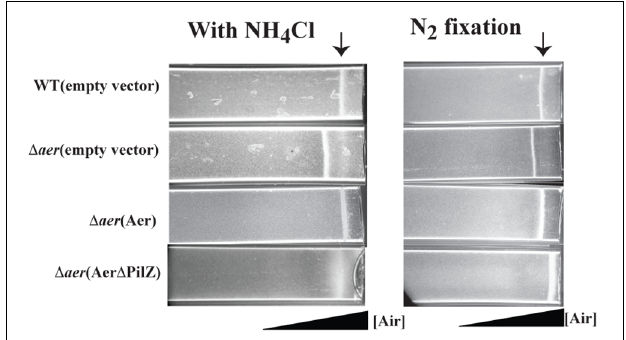
FIGURE 2 | Effect of loss of Aer on oxygen sensing in a spatial assay for aerotaxis. Cells grown in presence of ammonium chloride or grown in the absence of combined nitrogen and under condition of nitrogen (N 2 ) fixation before being were placed in a capillary tube. Over 95% of cells are motile under these conditions. An oxygen gradient is generated by diffusion of air into the suspension of motile cells. WT cells accumulate in a tight band at an oxygen concentration optimum for metabolism (arrow). Representative images are the result of 3 biological